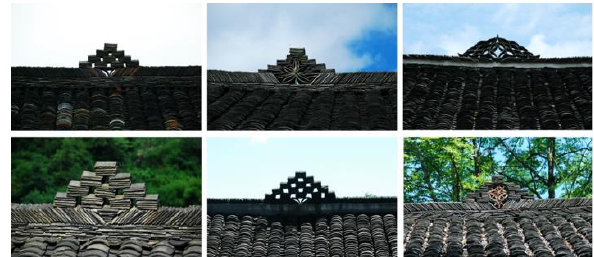
Figure 22. The Ridge